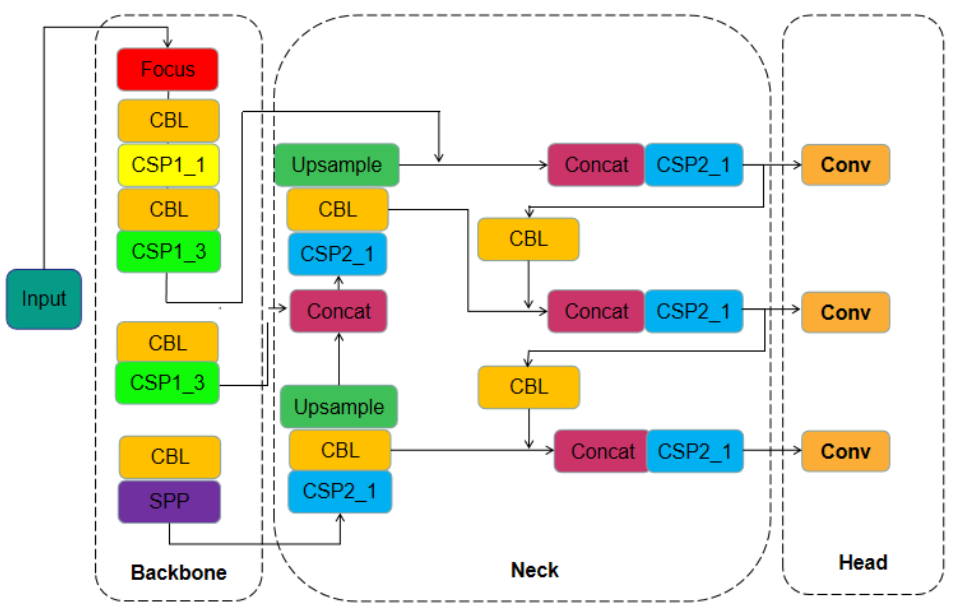
Figure 1. The architecture of YOLOv5.